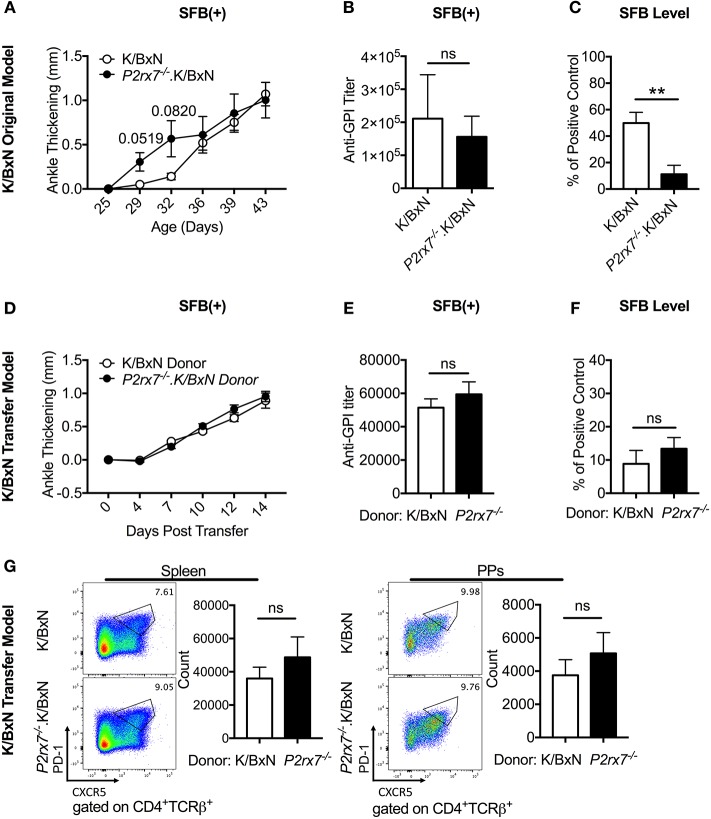
SFB colonization negates the difference in disease severity between WT and P2rx7−/− mice in the original K/BxN model and K/BxN T cell transfer model. (A–G) K/BxN mice (A–C) or TCRα−/−. BxN mice (D–G) were gavaged with SFB 1–2 days after weaning. (A) Ankle thickness was followed over time for K/BxN and P2rx7−/−.K/BxN mice between ~3.5 and 6 weeks of age. Data are shown as change in ankle thickness compared to first measurement. Error bars represent SEM. N = 7–17/group, multiple litters combined. (B) Anti-GPI auto-Ab titers in serum obtained from mice 5–7 weeks old were measured by ELISA. N = 8–11/group, 5 assays combined. (C) SFB level 10 days after gavage was determined by quantitative PCR on 16S rDNA, normalized to a standardized positive control. N = 5–12/group, 5 assays combined. (D–G) SFB(+) TCRα−/−.BxN recipients were given either K/BxN or P2rx7−/−.K/BxN CD4+ cells retro-orbitally at 6 weeks of age. (D) Ankle thickness was followed beginning at day of transfer for TCRα−/−.BxN mice transferred with either K/BxN or P2rx7−/−.K/BxN CD4+ cells. Data are shown as change in ankle thickness compared to first measurement. Error bars represent SEM. N = 12/group, 3 assays combined. (E) Anti-GPI auto-Ab titers in serum obtained from the end point of each experiment were measured by ELISA. N = 12/group, 3 assays combined. (F) SFB level determined by quantitative PCR on 16S rDNA, normalized to a standardized positive control. Feces were collected at end point of each experiment (14 days after T cell transfer which was equivalent to 5 weeks after SFB gavage). N = 23–24/group, 5 assays combined. (G) Representative plots and compiled graphs of spleen and PP Tfh numbers. N = 11/group, 3 assays combined. **p < 0.01.